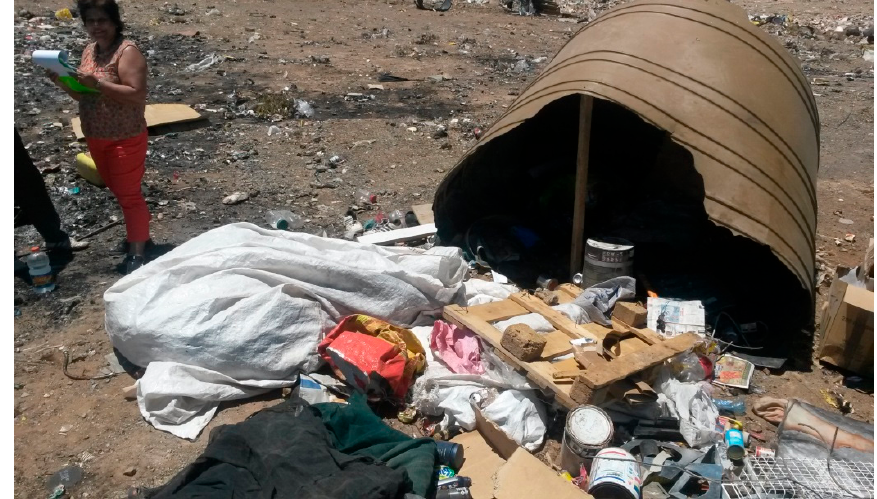
Figure 3. A ‘structure’ in which a waste picker sleeps on the landfill and which provides shade during the